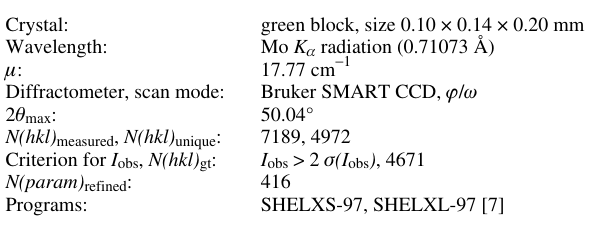
Table 1. Data collection and handling.